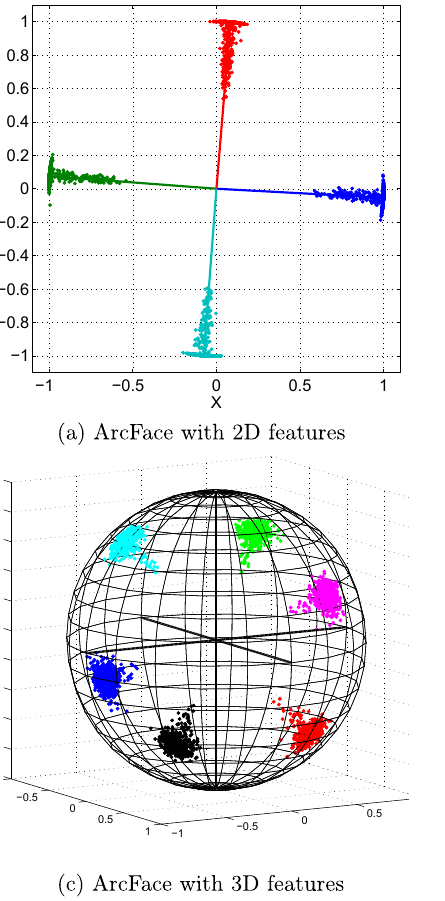
Figure 3. Visualization of features learned by the ArcFace function ( a , c ) without and ( b , d ) with the Orthant loss, respectively. Each class has a different color and each point represents a